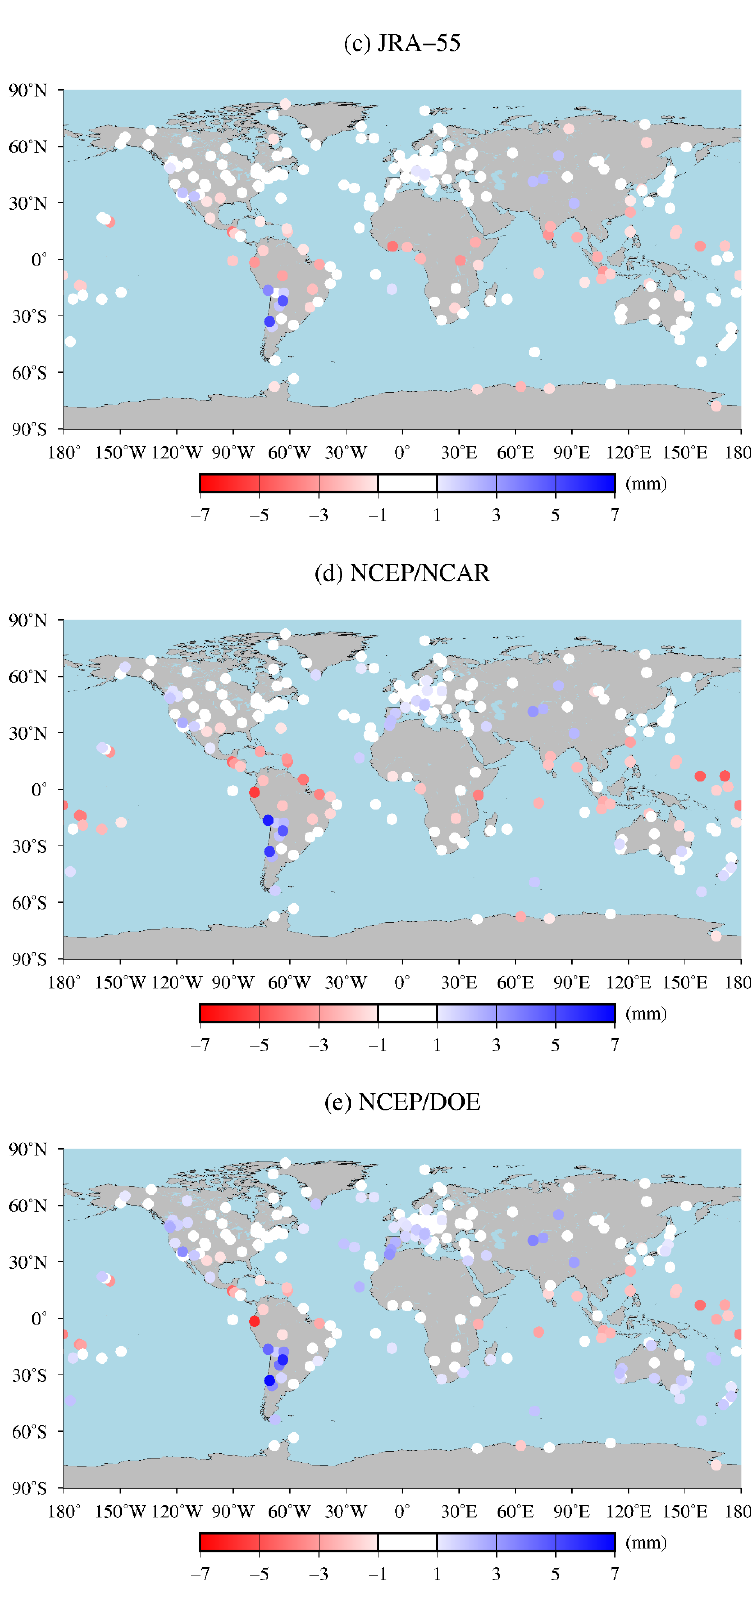
Figure 3. Bias values for ( a ) ERA5, ( b ) ERA-Interim, ( c ) JRA-55, ( d ) NCEP / NCAR, and ( e ) NCEP / DOE reanalysis water vapor products relative to GNSS PWV around the world (source: own elaboration).